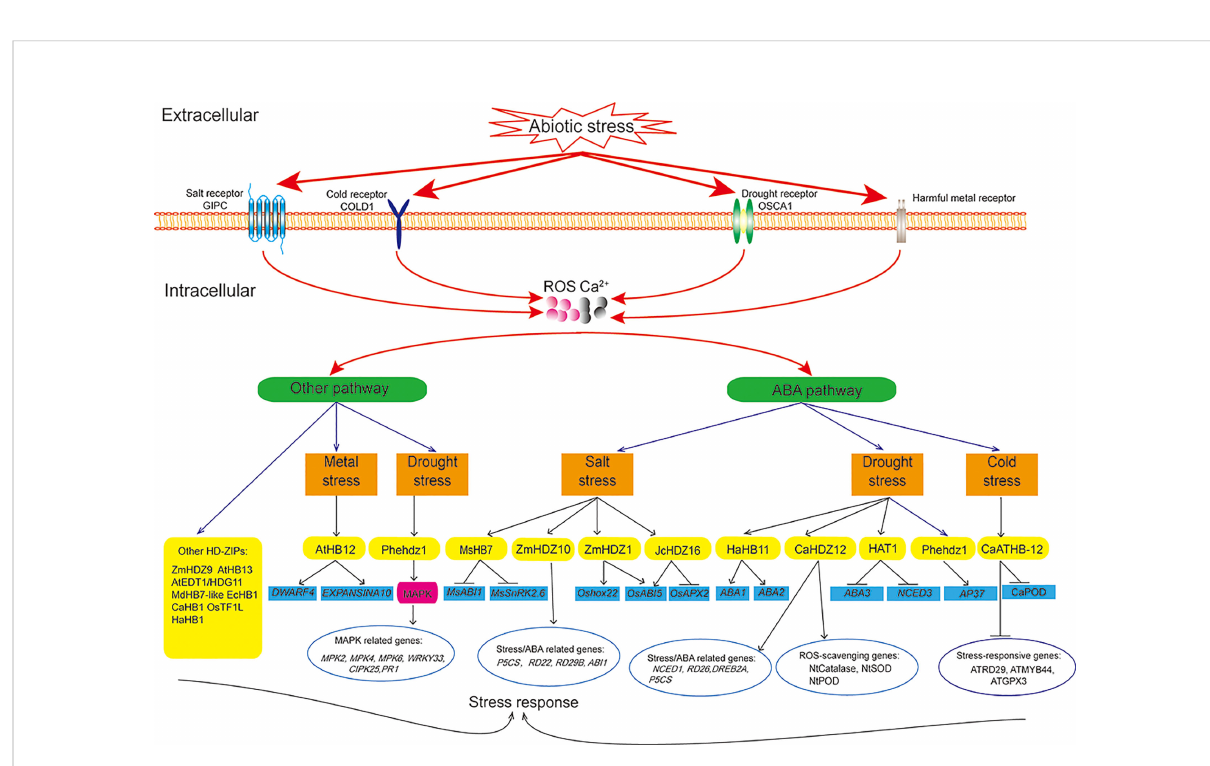
FIGURE 4 Molecular mechanism of HD-ZIP proteins under abiotic